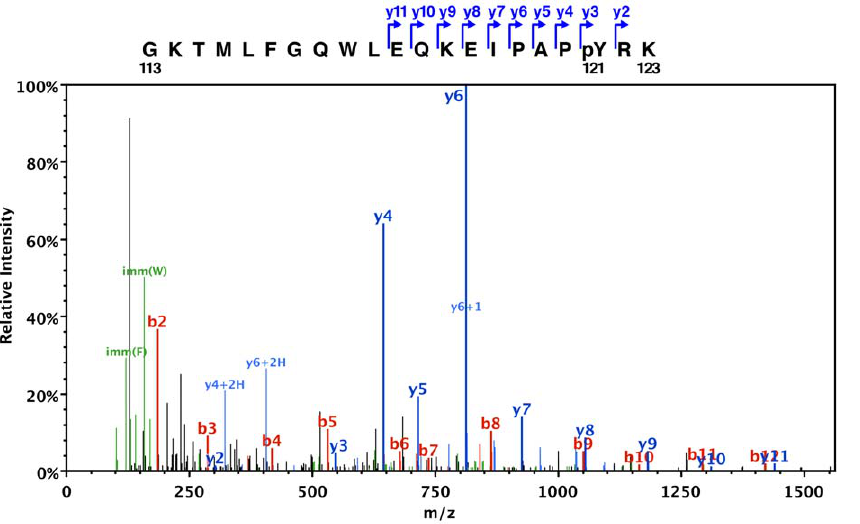
Figure 4. ESI tandem mass spectrometry confirms the presence and location of the phosphorylated tyrosine. The ESI-MS/MS fragmentation spectrum of Etp peptide GKTMLFGQWLEQKEIPAP(pY)RK (residues 113–123, pY is the phosphorylated tyrosine). The parent peptide was a + 4 H ion with mass 2599.29 amu ( 2 0.0134 amu from predicted size). The schematic at the top of the figure shows the identified y fragments referred to in the spectra. All of the y fragments include the peptide’s C-terminus and have masses consistent with the phosphorylated Y121 (pY) residue. For example, the m/z for fragments y3 and y2 are 546.2 and 303.2, respectively. The difference 243 is the exact mass of a phosphotyrosyl residue. The labeled b fragments originate at the N-terminus of the peptide but do not include the pY